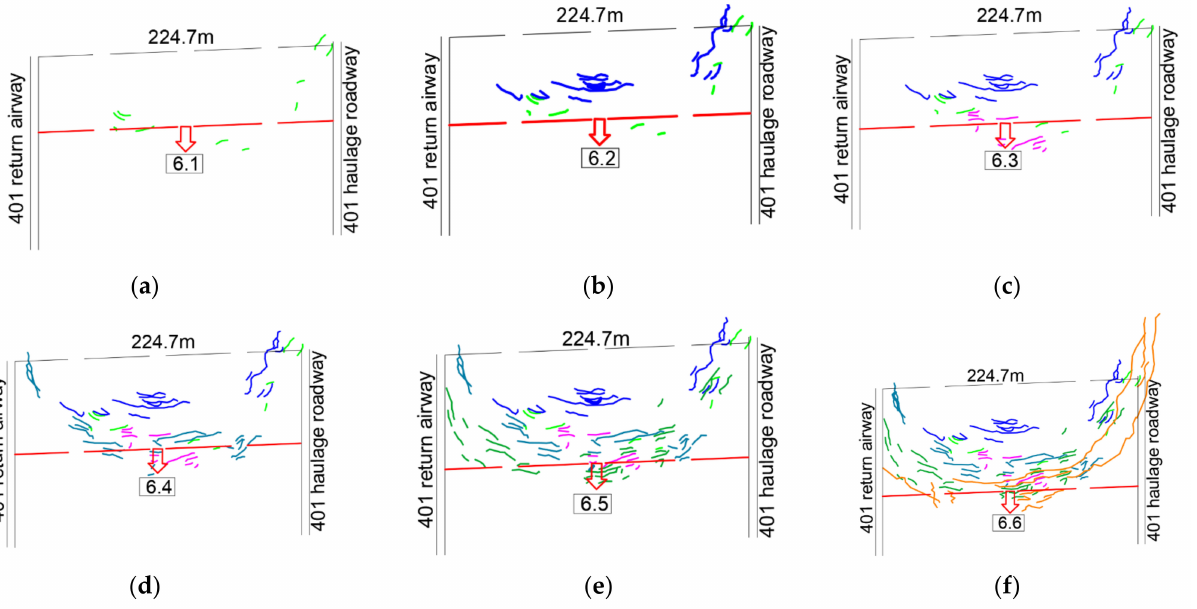
Figure 14. The extension process of surface cracks: ( a ): surface cracks directly above the working face overtake the development of the advancing position of the working face; ( b ) during the advancing process of the working face, surface cracks expand along the advancing direction of the working face on the one hand, and on the other hand gradually expand gradually from directly above the working face to both sides of the mining area until near the boundary of the mining area; ( c ) surface cracks develop suddenly directly in front of the working face, indicating that the development of cracks with suddenness; ( d ) surface cracks develop in the direction of the side of the mining area and the two roadways, but the cracks hardly develop forward; ( e ) surface cracks continue to develop at the boundary of the mining area; ( f ) the generation of cracks at the boundary of the mining area usually delays the advancing position of the working face, and large cracks are formed at the